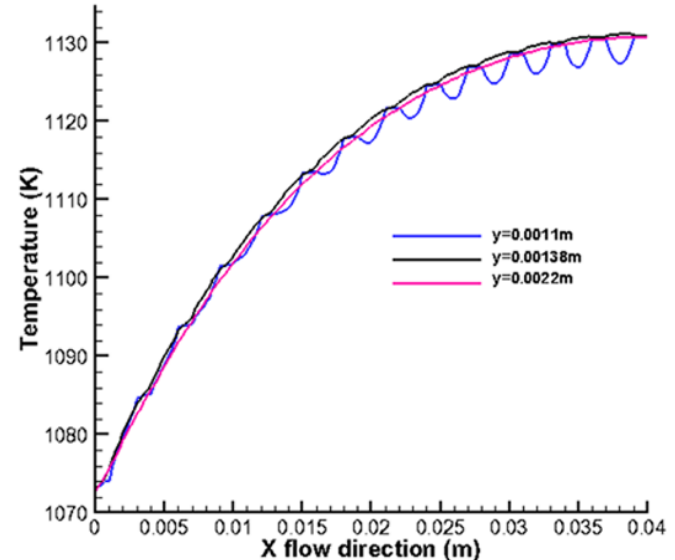
Figure 5. Temperature (K) distribution along the fuel main flow direction in the plane ( z = 0.02 m) at positions of y = 0.0011 m, 0.00138 m and 0.0022 m for